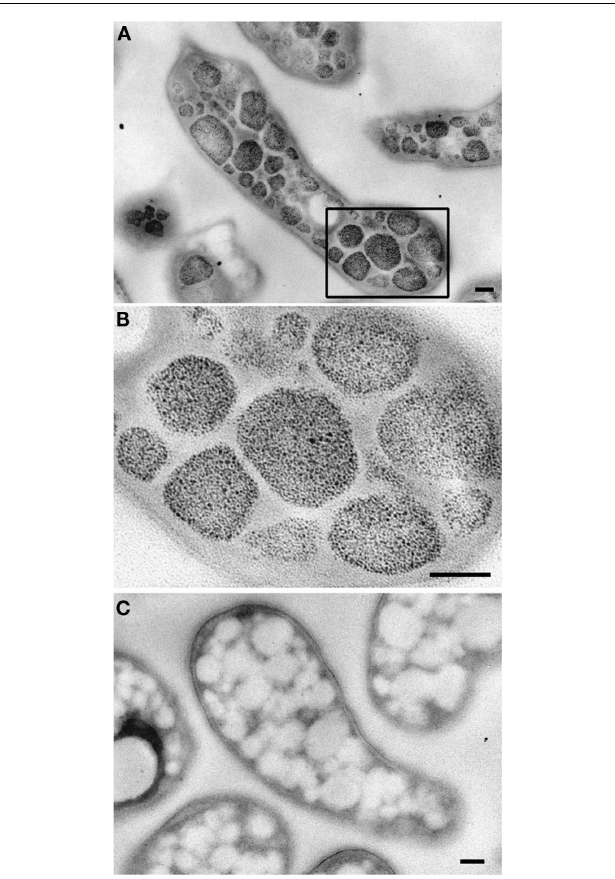
FIGURE 6 |Transmission electron micrographs showing glycogen staining of chemically fixed, Epon-embedded thin sections of “ Ca. M. fumariolicum” cells in transition phase II. (A) Glycogen staining is seen in the otherwise electron light particles abundantly present in the cytoplasm. (B) Zoom-in of the box drawn in (A) . (C) Negative control incubated with water instead of periodic acid. Scale bars,